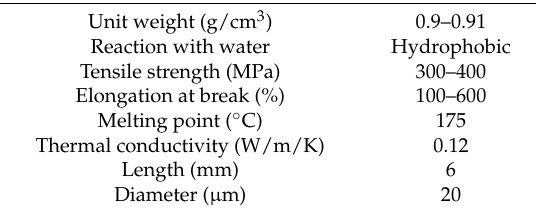
Table 3. Properties of polypropylene fibre.